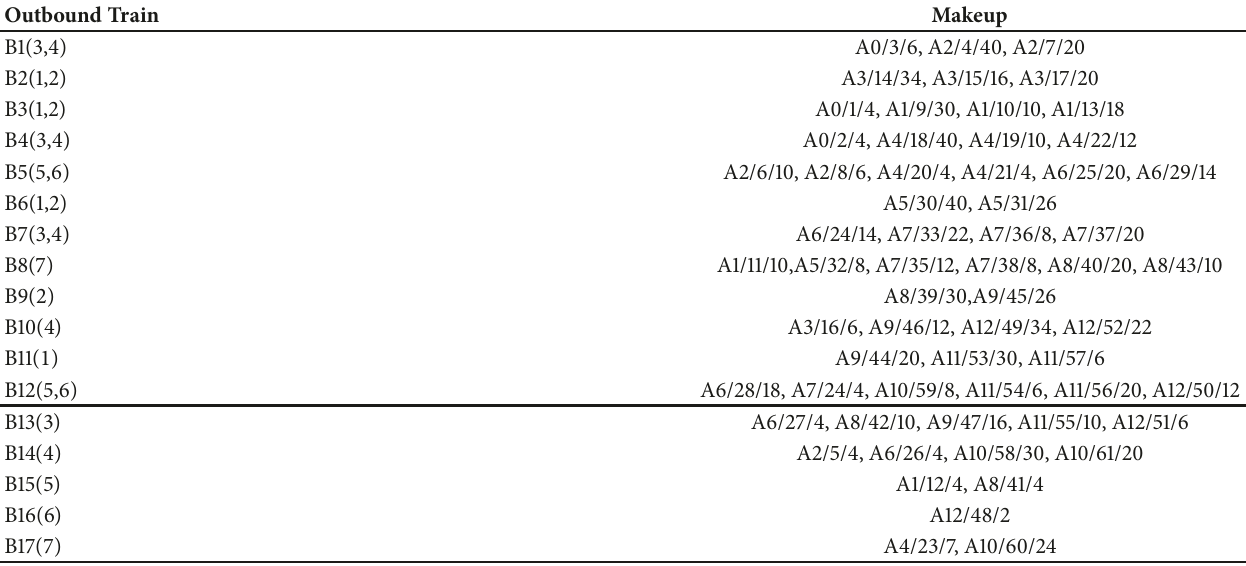
Table 4: Railcars connection plan.